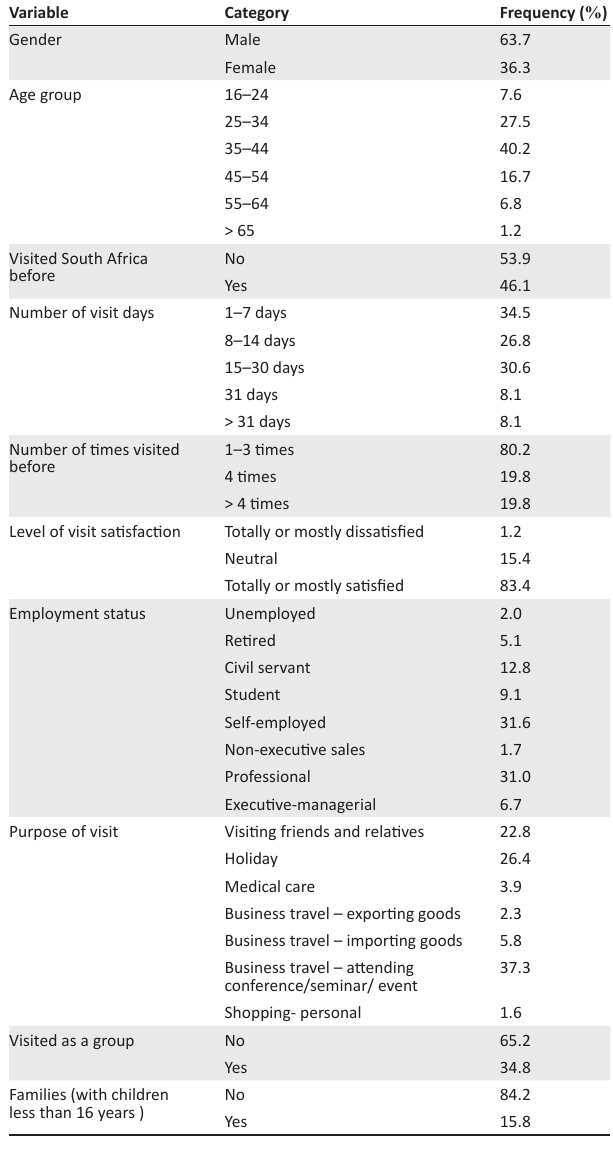
TABLE 1: Profile of the respondents ( n =